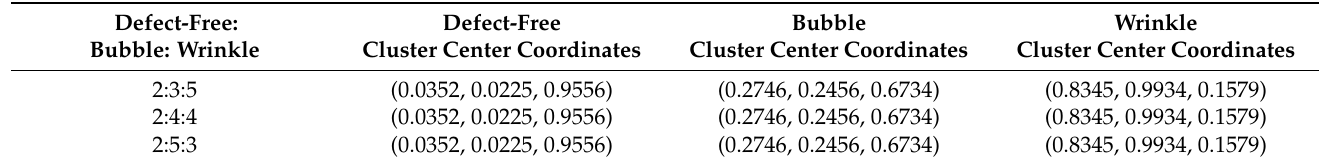
Figure 13. Plot of KMC algorithm classification for the three conditions with proportions of ( a ) 2:3:5, ( b ) 2:4:4, and ( c ) 2:5:3. Table 4. The initial cluster center of three surface morphologies with different proportions.